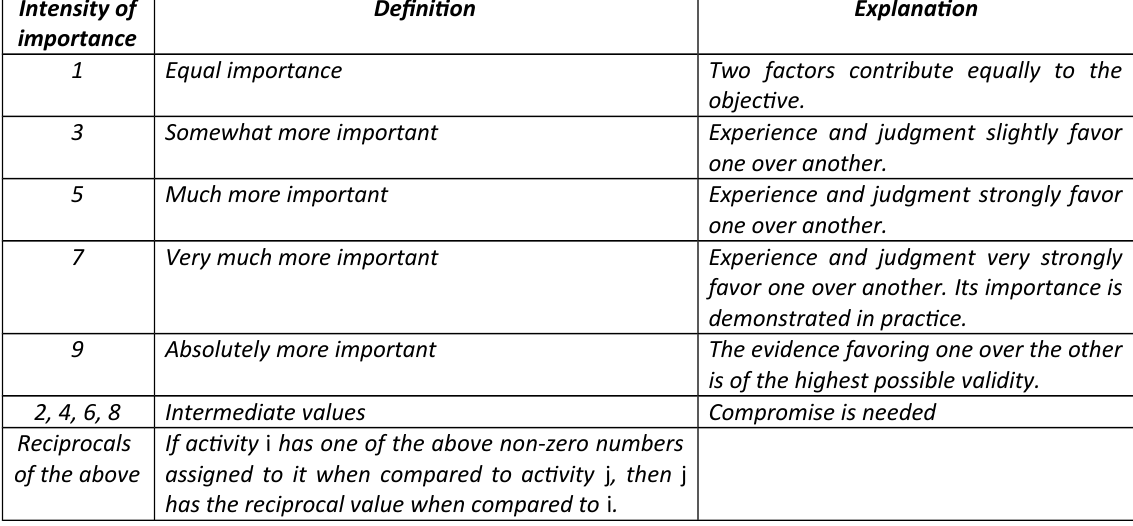
Table 2. The fundamental scale of absolute numbers